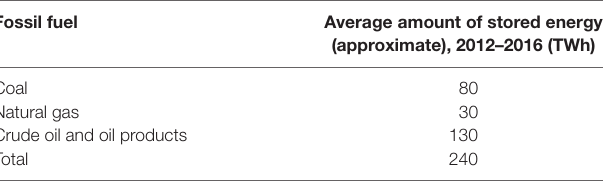
taBLe 1 | Average amounts of stored energy in fuels in Great Britain from 2012 to 2016. Fossil